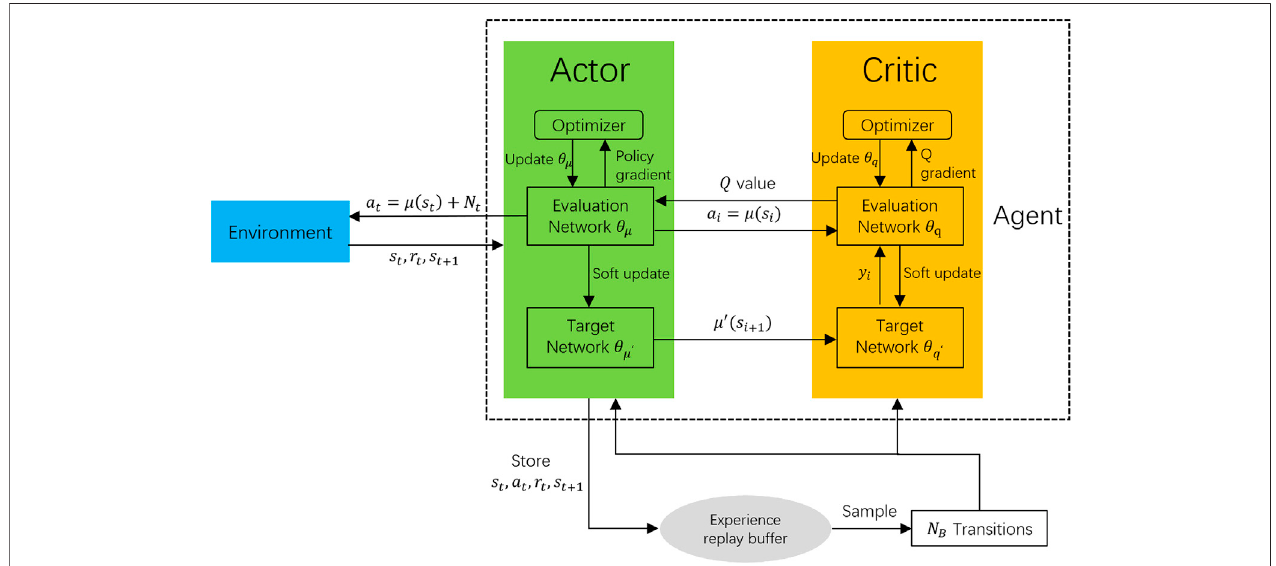
FIGURE 2 | Framework of DDPG.